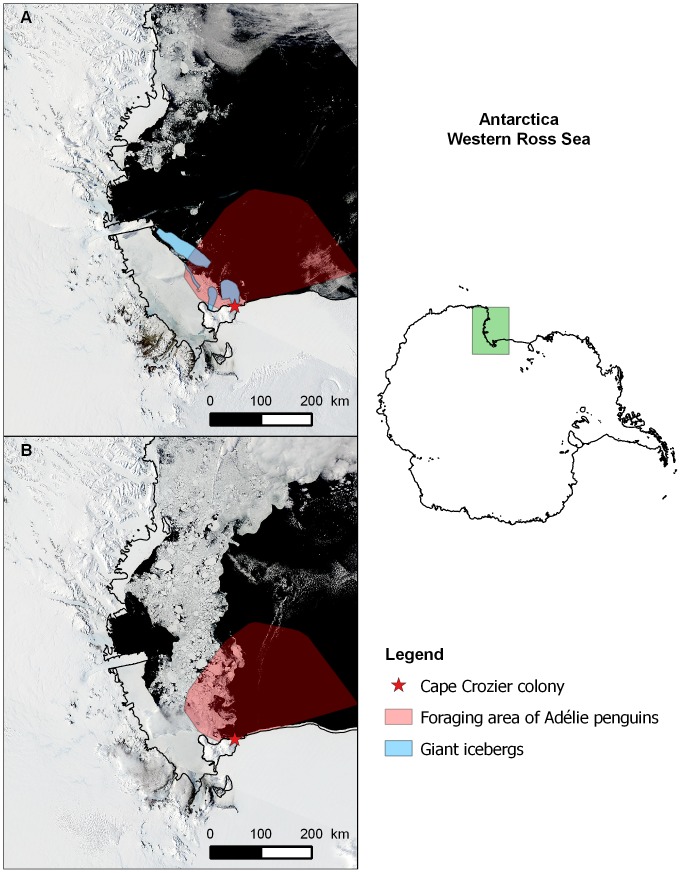
Map of the study area indicating the colony location (star), the foraging area of Adélie penguins (in red) and the location of giant icebergs.The satellite images are from http://lance-modis.eosdis.nasa.gov and illustrate A: a typical iceberg year (Dec. 21, 2004), B: a typical non-iceberg year (Dec. 21, 2008). The foraging area was determined as the polygon that contained 95% of at-sea positions of provisioning parents as determined by radio and satellite telemetry from 1997/1998 to 2008/2009.